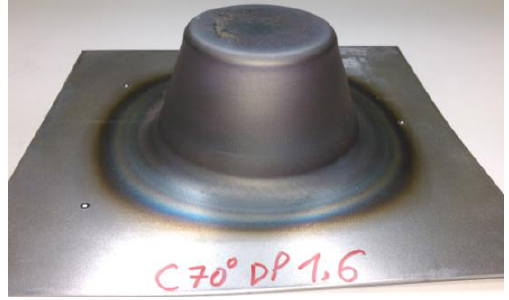
Figure 10. A 70° cone wall angle by a varied feed rate made form HCT980C steel. Figure 10. A 70 ◦ cone wall angle by a varied feed rate made form HCT980C